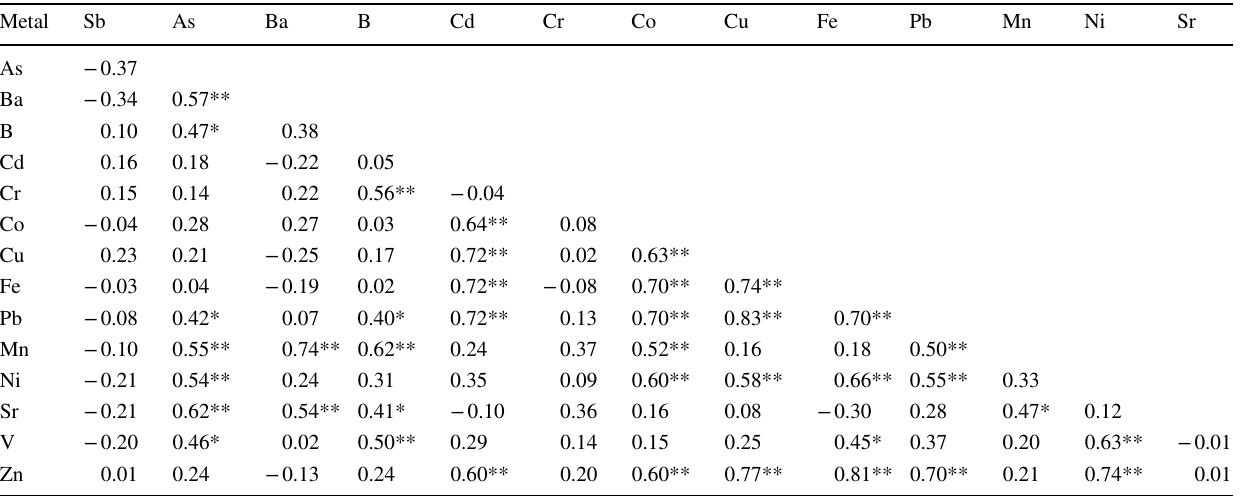
Table 4 Pearson’s correlation coefficient between elements in the river water (n = 26) (Aschale et al. 2015)